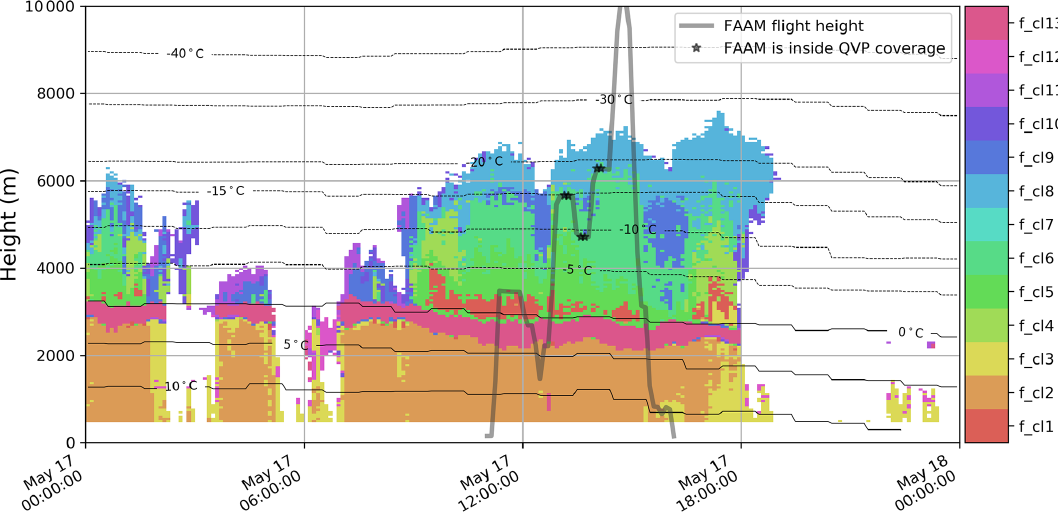
Figure 6. The height vs. time format of the final optimal set of active clusters found by the top-down hierarchical clustering for the QVP input data described in Table 1. (The hierarchical structure behind the optimal clustering is found in Fig. 4.) Example of clusters in the height vs. time format of the 17 May 2017 QVPs presented in Fig.